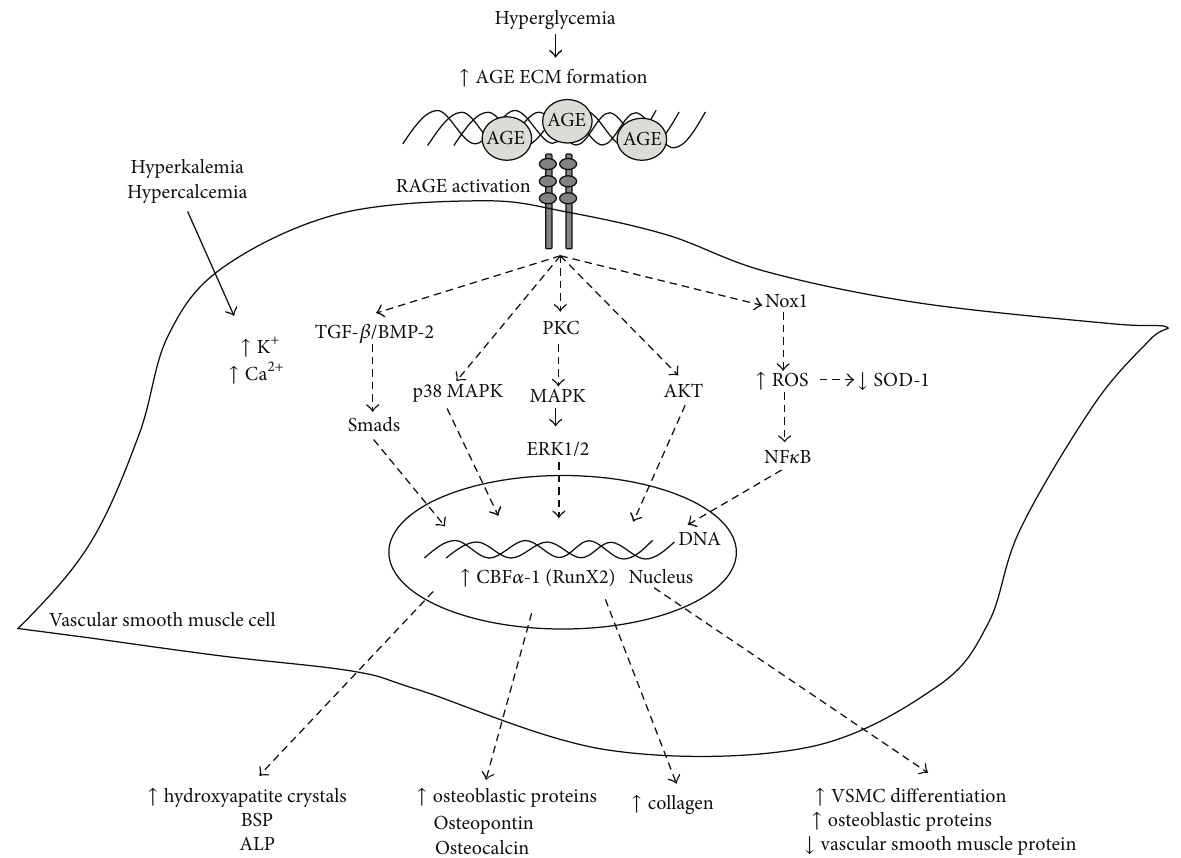
Figure 1: Schematic of AGE/RAGE signaling in diabetes-mediated vascular